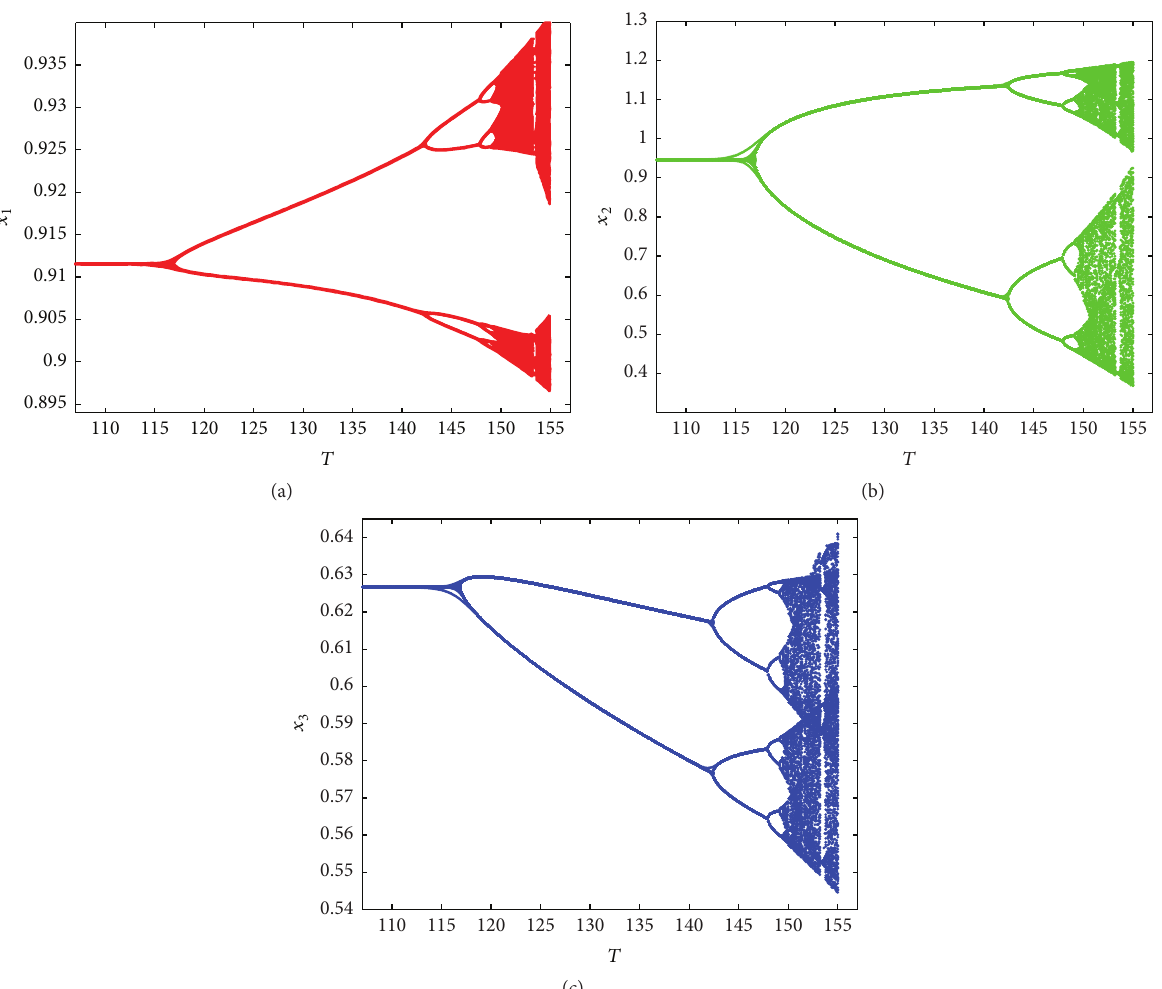
Figure 4: Bifurcation diagrams of system (4) with 𝑥 1 (0) = 0.7, 𝑥 2 (0) = 0.8, 𝑥 3 (0) = 0.5 . The system exhibits stable solution, periodic doubling bifurcation, and chaotic phenomenon corresponding with different 𝑇 . (a) is the bifurcation diagram of population 𝑥 1 (𝑡) ; (b) is the bifurcation diagram of population 𝑥 2 (𝑡) ; (c) is the bifurcation diagram of population 𝑥 3 (𝑡)